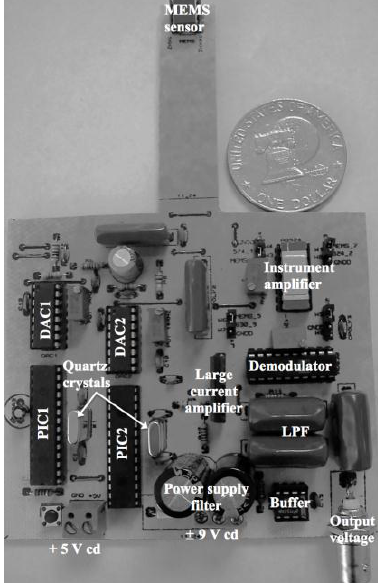
Figure 23. Printed circuit board (PCB) for a portable signal conditioning system of a MEMS sensor, which could be used for monitoring residual magnetic field of ferromagnetic materials [37]. Reprinted